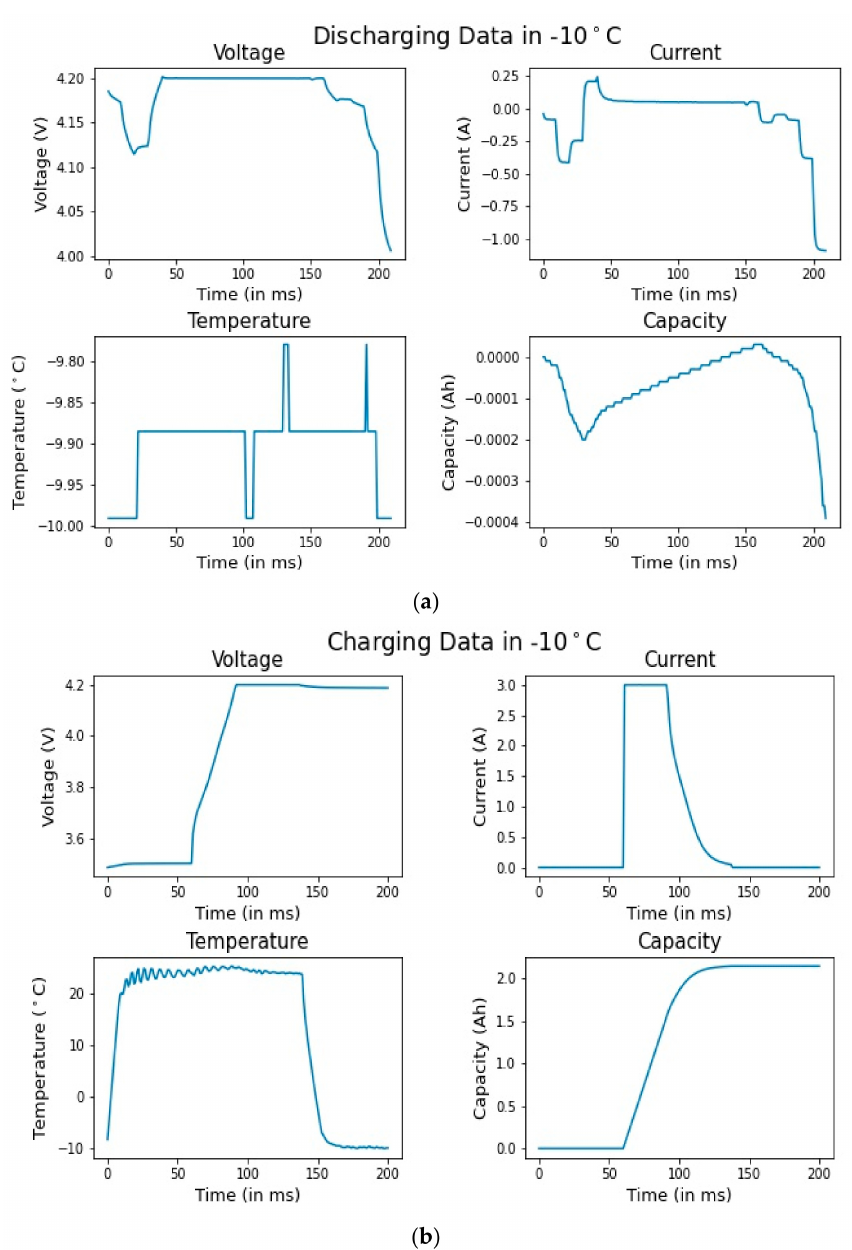
Figure 1. Sample data plot for the measured parameters of the terminal voltage, current, temperature, and battery capacity (Ah) while ( a ) discharging and ( b ) charging the battery at − 10 ◦